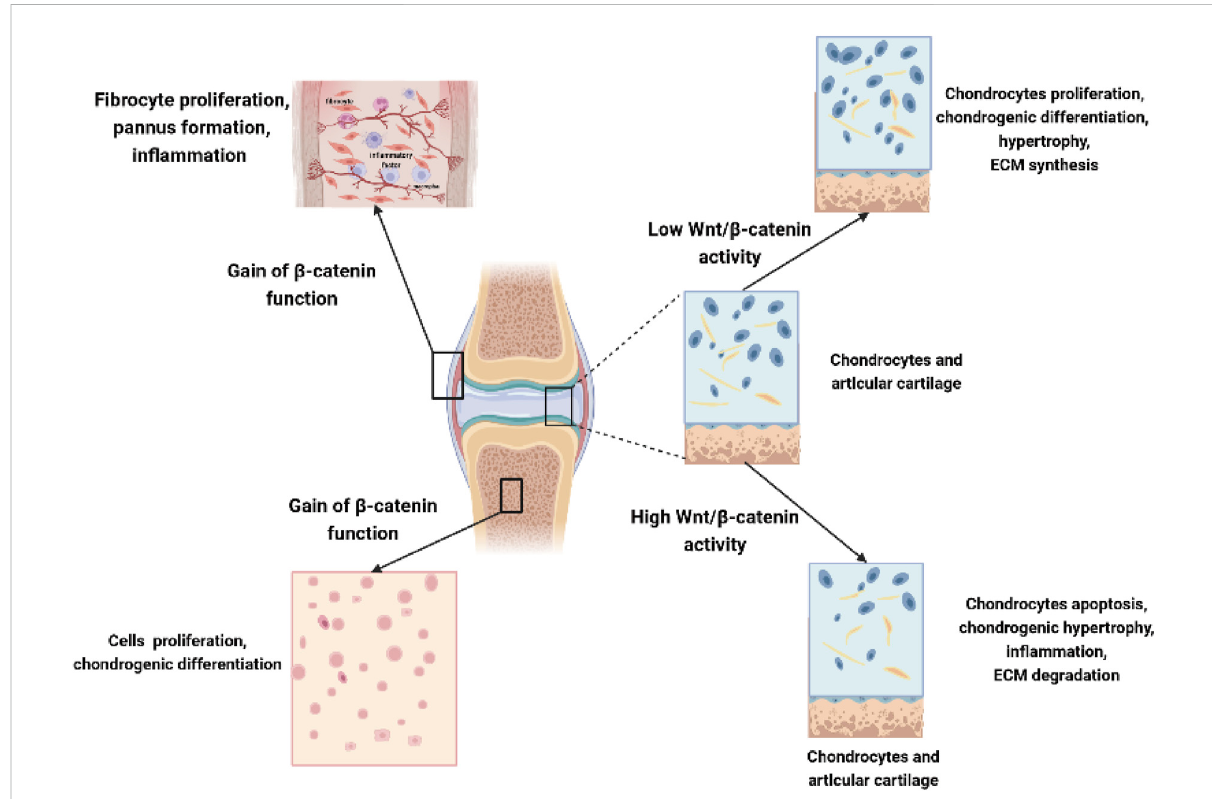
FIGURE 3 Complex role of Wnts in chondrocytes, synoviocytes, and mesenchymal stem cells. Low Wnt/ β -catenin activity in chondrocytes promotes chondrocyte proliferation, chondrogenic differentiation, chondrocyte hypertrophy, and increased ECM synthesis, while high Wnt/ β -catenin activity leads to chondrocyte apoptosis, hypertrophy, increased in fl ammation, and degradation of ECM in joints. Overexpression β -catenin contributes to the fi brocyte proliferation, pannus formation, and local in fl ammation in synoviocytes; moreover, it could also promote the proliferation and chondrogenic differentiation of MSCs in